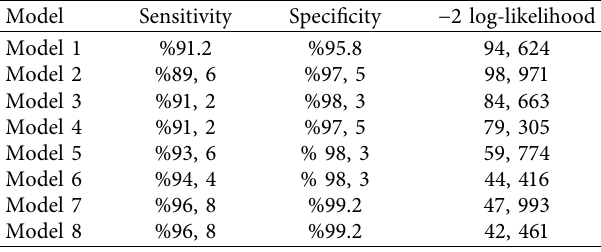
Table 5: Performance of the logistic regression analysis models for differentiating keratoconus eyes from normal eyes.